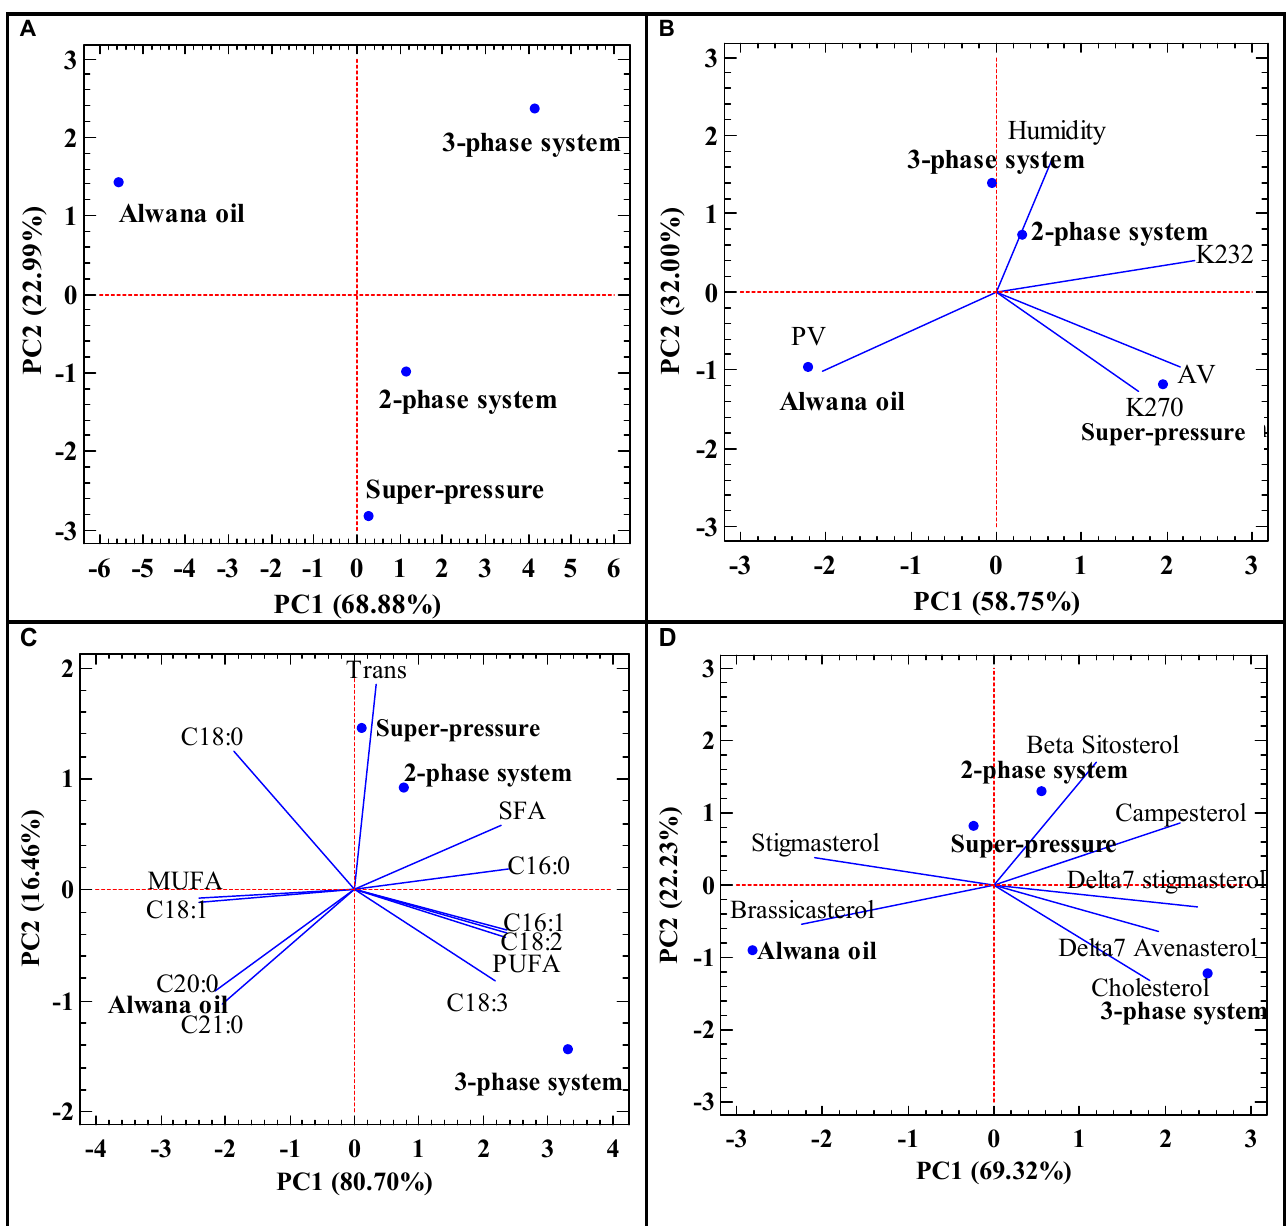
Figure 3. Principal component projections for the first three components that most impact the investigated olive oil physicochemical traits taken together ( A ), basic quality indices ( B ), fatty acids ( C ), and sterols composition ( D ). Blue segments represent dependent variables and points plotted represent mean values. AV = acid value, PV = peroxide value, UV absorption coefficients K232 and K270, SFA = saturated fatty acids, MUFA = monounsaturated fatty acids, and PUFA= polyunsatu- rated fatty acids.